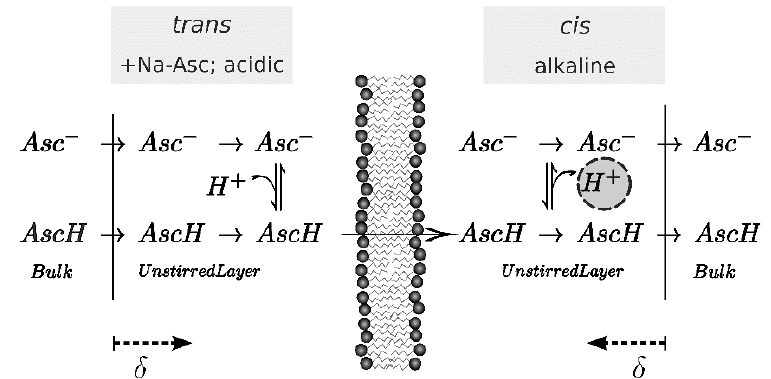
Figure 1. Scheme of the effect of pH shift upon one-sided addition of Na-Asc to the trans side of the membrane where an acidic pH ensures a high ascorbic acid (AscH) concentration. Once arriving on the alkaline cis-side, almost all acid molecules deprotonate and release a proton (encircled). Hence, the pH drops on the cis in the vicinity of the membrane. Since each compartment is stirred, this effect is occurring only within the unstirred layer of thickness δ . Scanning electrochemical microscopy serves to measure this pH shift.